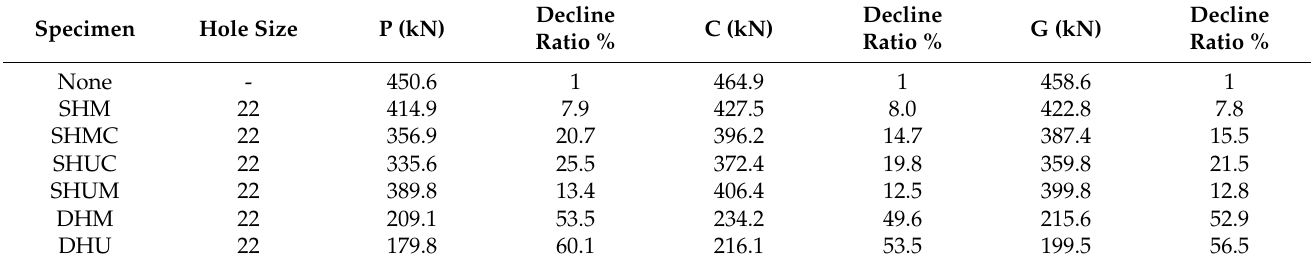
Table 3. The results of the specimens with different opening locations and number of